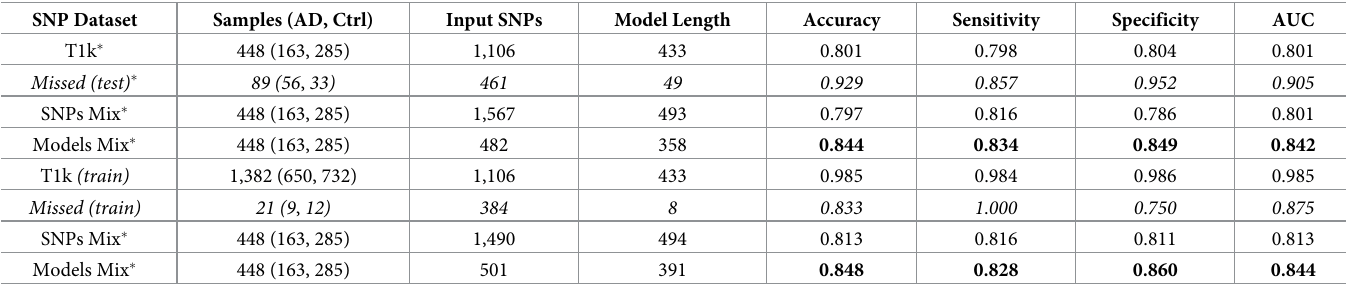
� Indicates that the evaluation was performed in the test set. AD, CTRL refer to Alzheimer’s Disease and Control